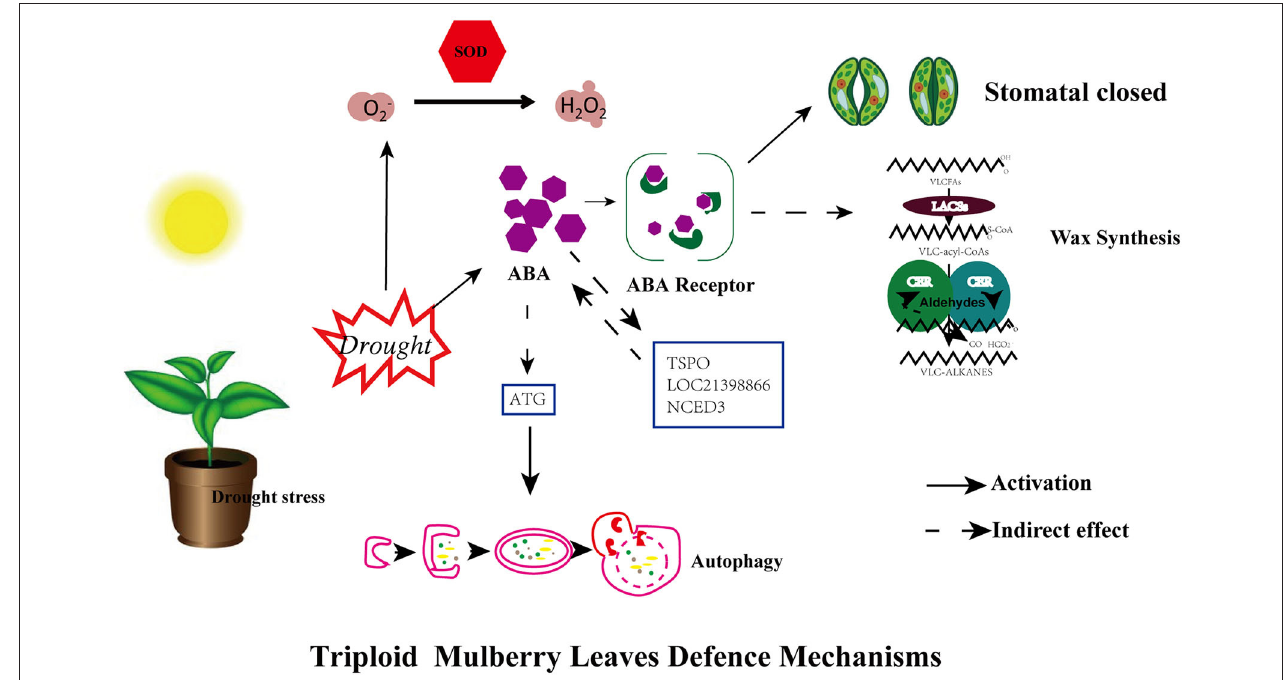
FIGURE 7 | A model for mechanisms underlying the enhanced drought tolerance of mulberry triploid (3X). Under drought stress, triploid plants exhibit enhanced drought tolerance in comparison with diploid progenitors due to the activation of multifaceted defense machinery in leaves. For the first, activation of ABA hormonal signaling and antioxidant enzyme (SOD) leads to efficient hormonal signaling and improved ROS scavenging ability, and ABA-induced stomatal closure concurrently. Secondly, some genes (TSPO, NCED3, and LOC21398866) and ATG gene related to ABA signaling showed significant upregulation in expression. Autophagy is regulated by autophagy-related (ATG)gene, meanwhile, wax load